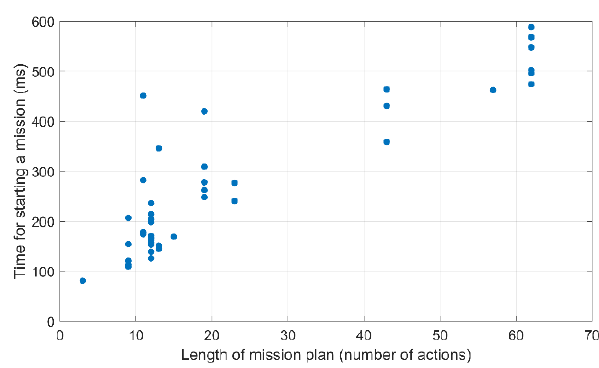
Figure 27. Relation between the length of the mission plan and the time required to start it.